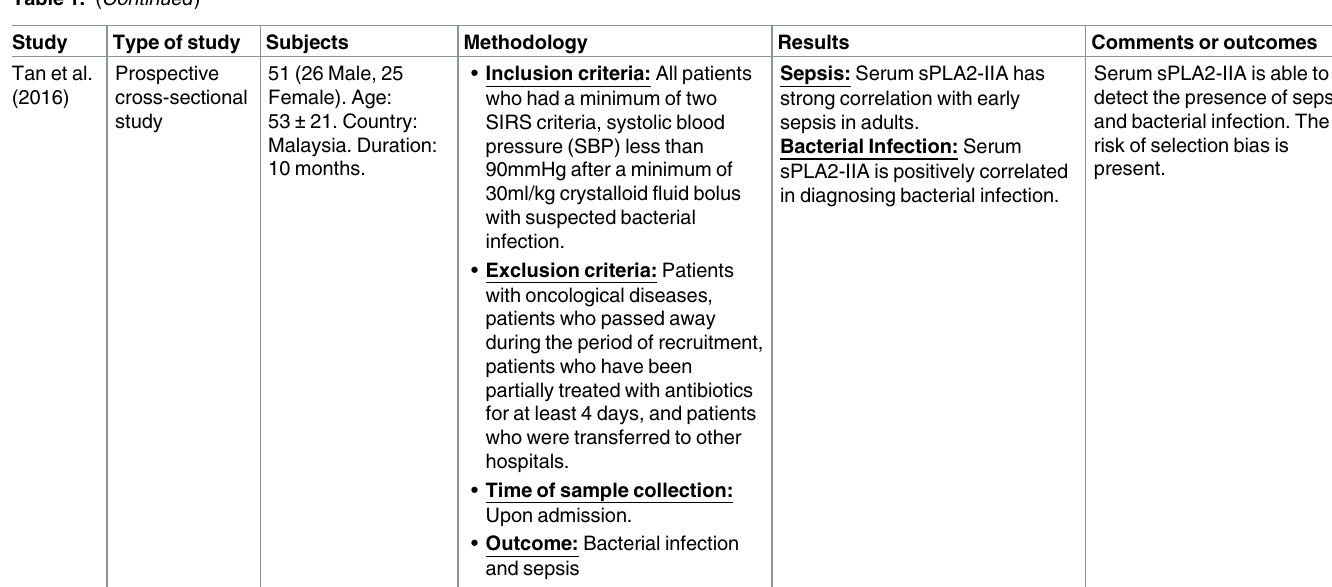
Serum sPLA2-IIA is able to detect the presence of sepsis and bacterial infection. The risk of selection bias is